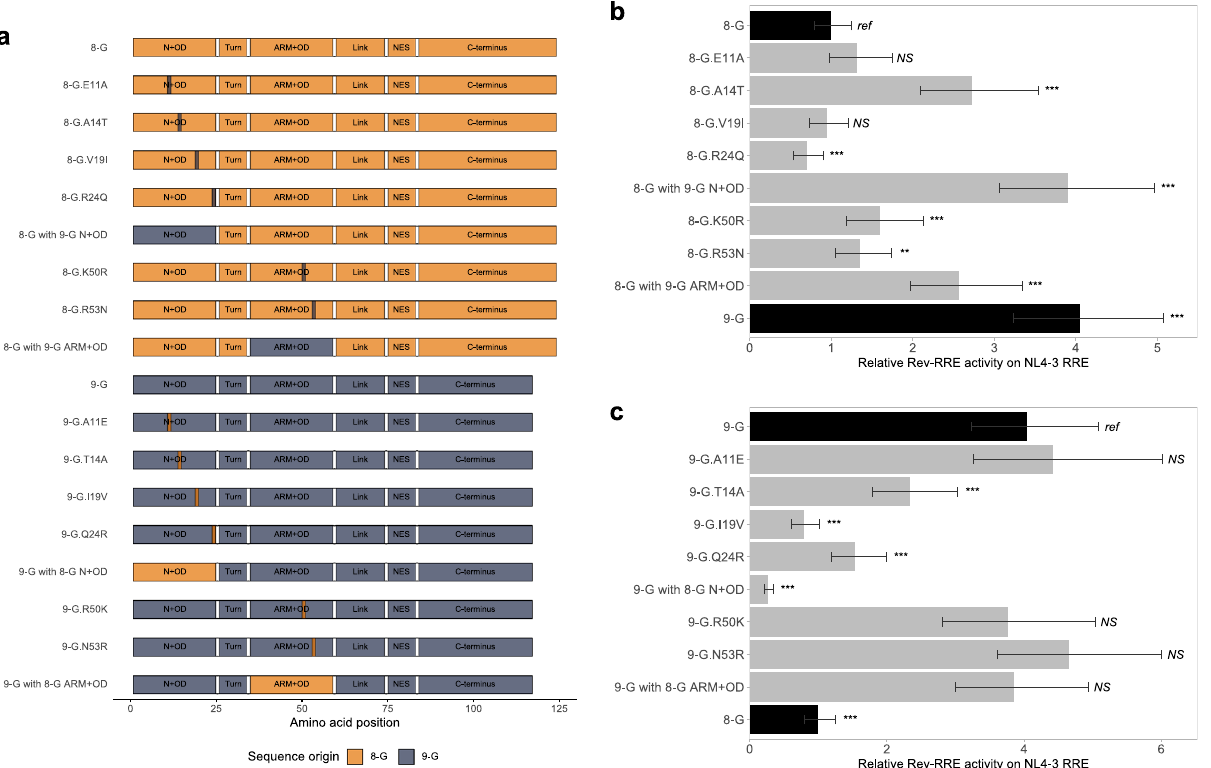
Figure 4. Activity of Revs with single amino acid substitutions on NL4-3 RRE. 8-G and 9-G Revs with single amino acid substitutions within the N-terminal, OD, or ARM regions were created. A schematic of each Rev used in this set of experiments is shown in ( a ). Single amino acid substitutions are shown as a vertical bar on contrasting color at the indicated location. The functional activity of the 8-G ( b ) and 9-G ( c ) constructs was determined on the NL4-3 RRE using the fluorescence-based assay system. In each plot, the native 8-G and 9-G Rev sequences are included in dark bars for reference and modified Revs are in light bars. For both plots, relative activity is expressed in arbitrary units with the activity of the 8-G Rev/NL4-3 RRE defined as 1. The statistical comparison is performed in reference to the top-most Rev in each plot. N ≥ 3 for all data points, error bars represent 95% CI. N + OD—N-terminus plus first portion of the oligomerization domain, ARM + OD—arginine rich motif plus second portion of the oligomerization domain, NES – nuclear export signal. Ref —reference sequence for the plot, NS —not significant, *** p < 0.001, ** p <